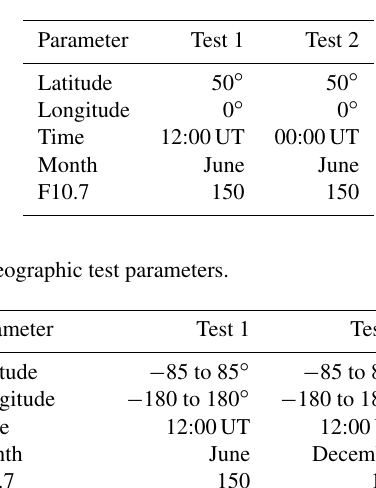
Table 2. Test parameters for height dependence examples